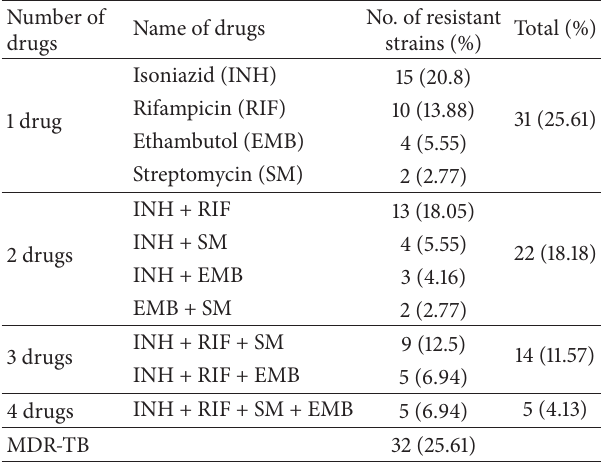
Table 2: Resistance pattern of 72 drug resistant strains of MTB to four ATT